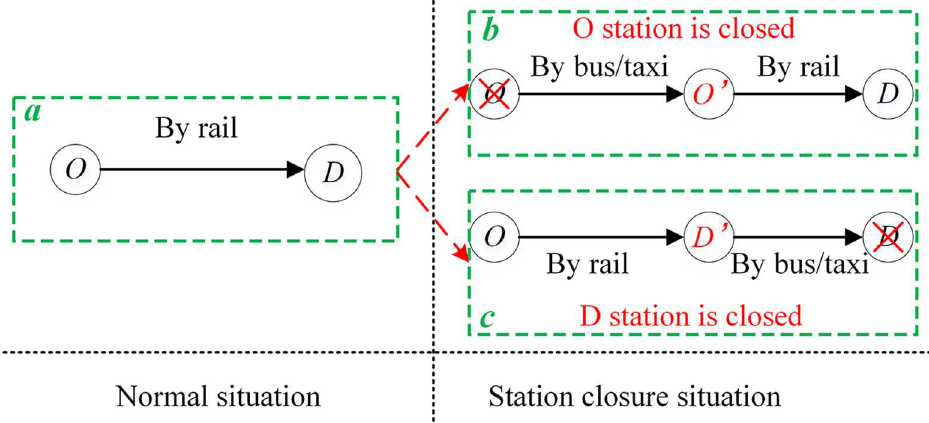
considered in our studies for station